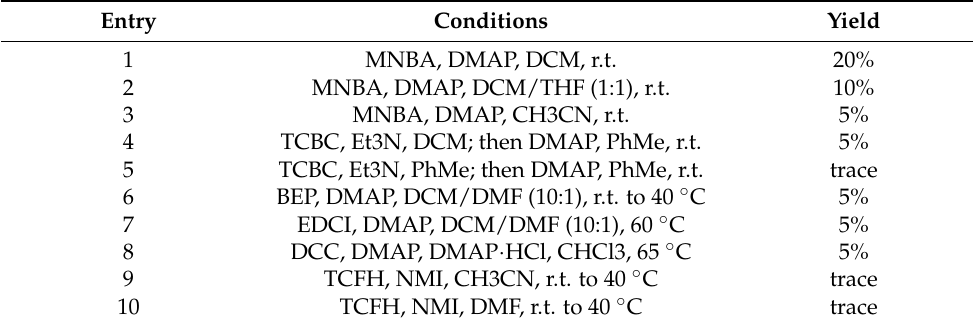
Table 1. Optimization of